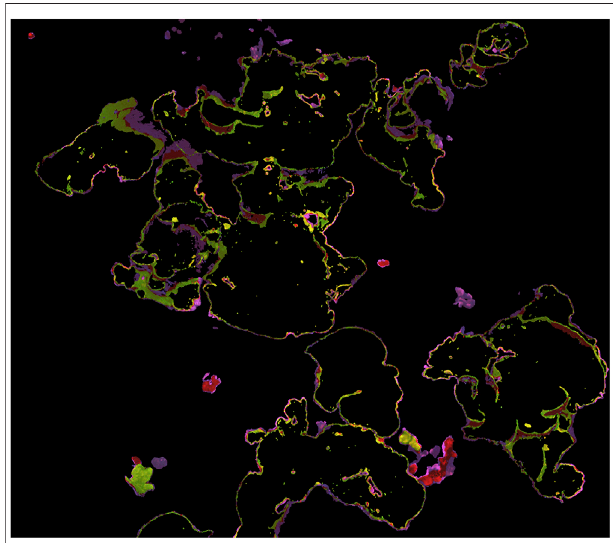
FIGURE2| 3Dmodelshowingmanualsegmenter Porites disagreement only. Points highlighted yellow were labeled Porites by three of four segmenters, red by two, and purple by only one.